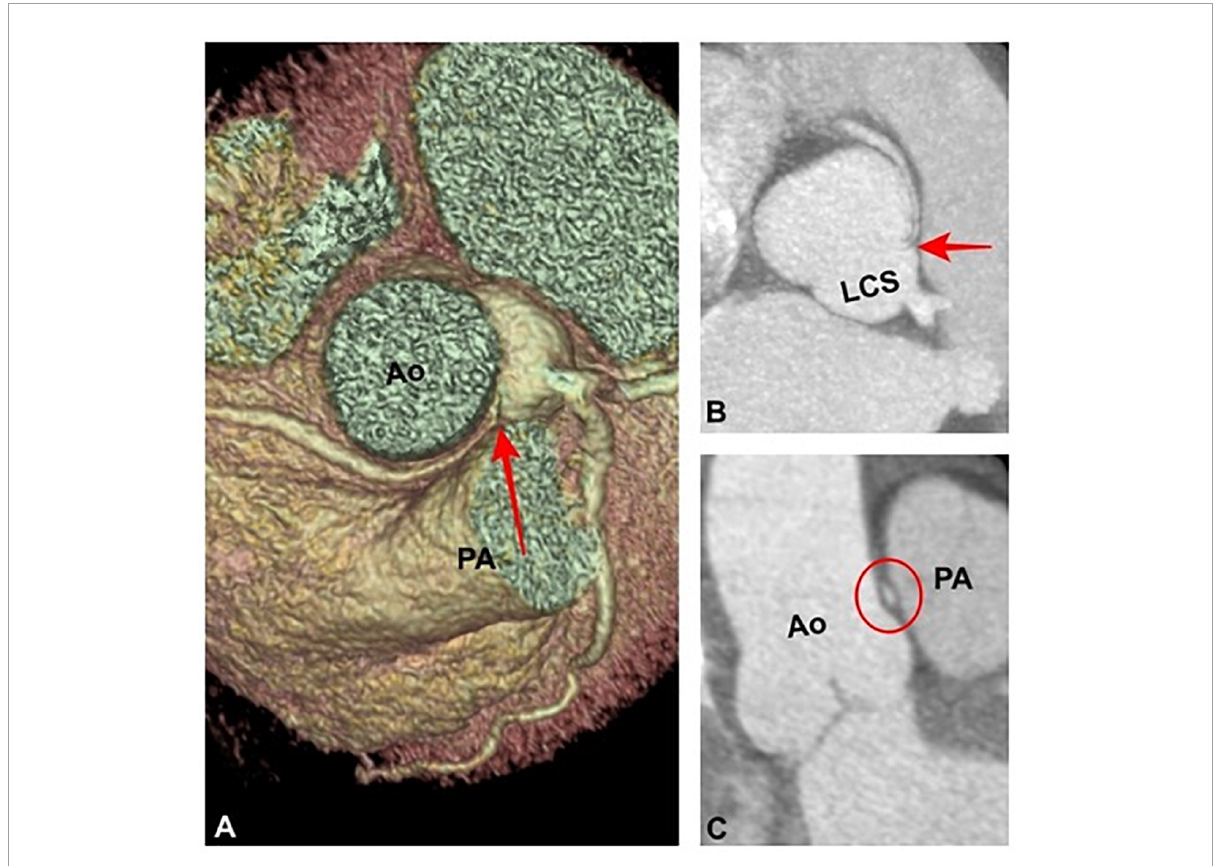
FIGURE2 (A) Volume rendering and (B) maximum intensity projection reformations demonstrating an anomalous origin of the right coronary artery from the left coronary sinus and an its intramural and interarterial course (red arrows). (C) Coronal oblique image shows an “elliptic shape” (red circle) of the interarterial course of the right coronary artery (high-risk feature). Ao, Aorta. PA, Pulmonary